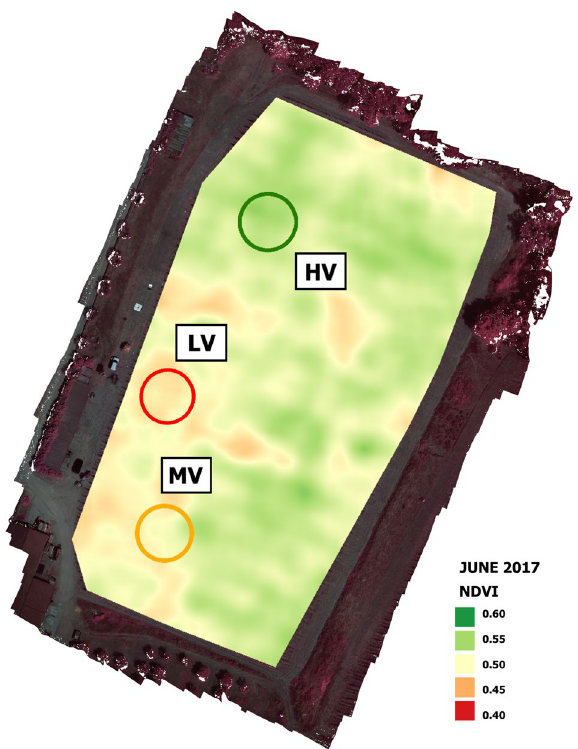
Figure 2. NDVI map created using UAV images acquired during the flight campaign in June 2017 with representative high vigour (HV), medium vigour (MV) and low vigour (LV)